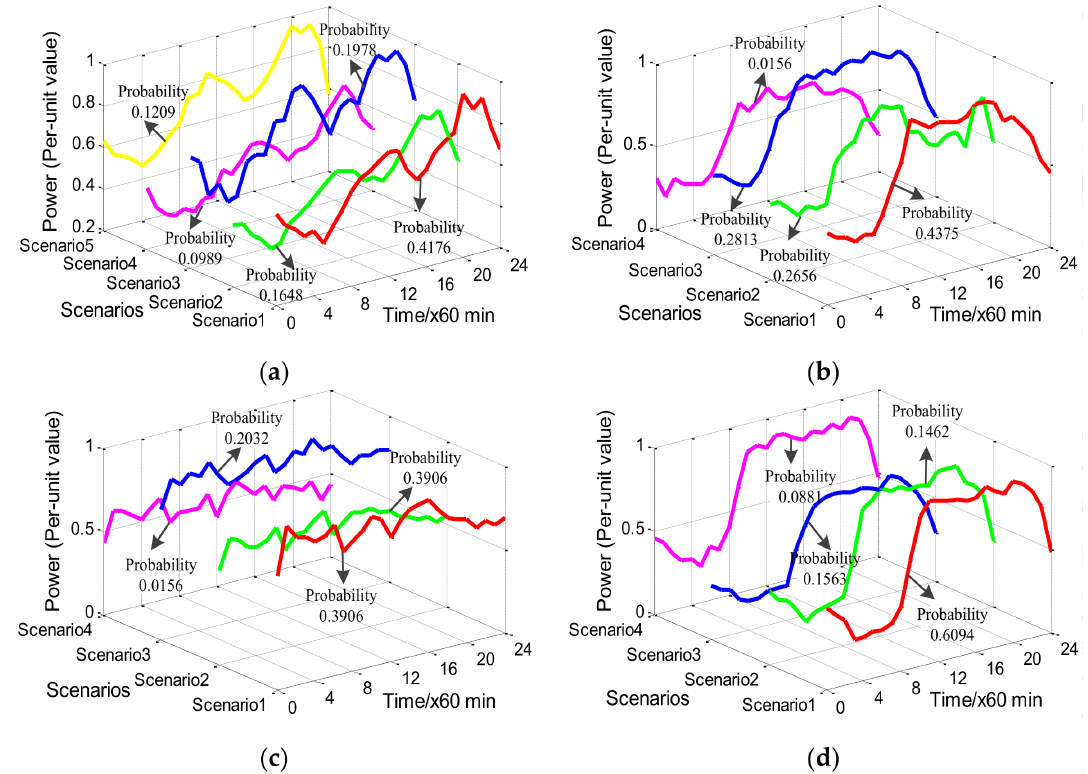
Figure 5. The timing scenarios of the summer electric load on weekdays for typical functional